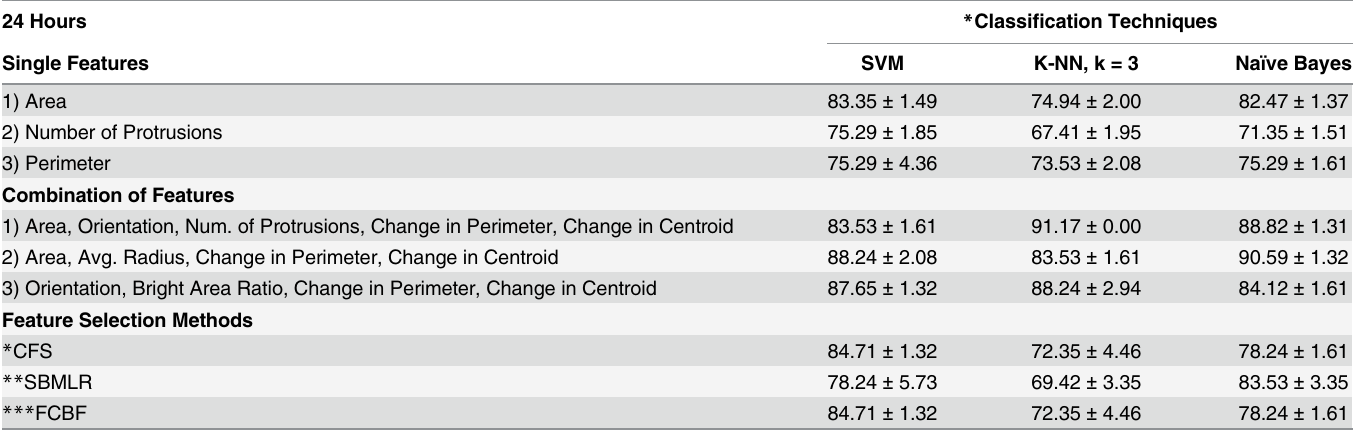
Table 3. Classification Results Using 24 Hours of Video.